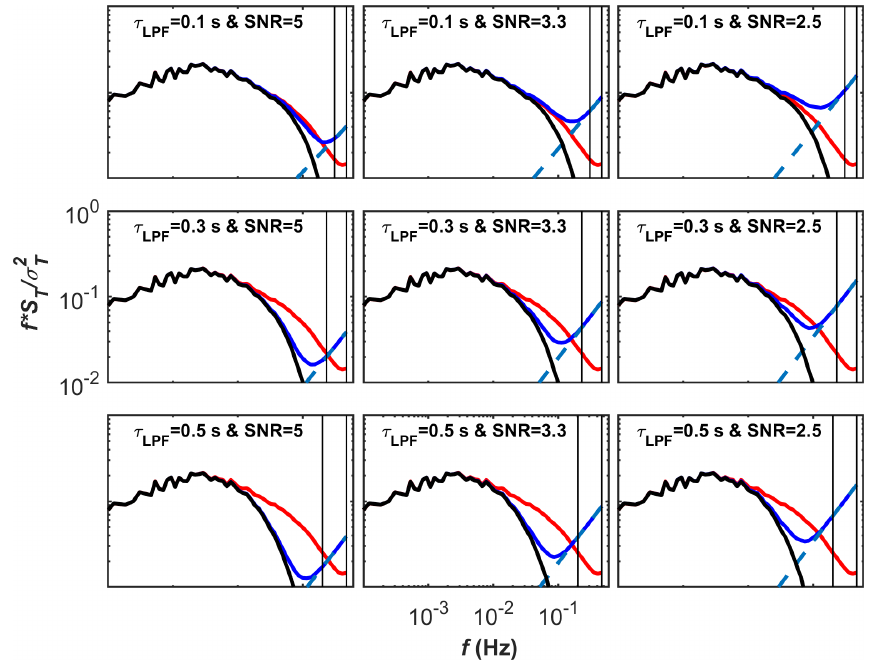
Figure 4. Effect of several low-pass filtering ( τ LPF = 0 . 1, 0.3, and 0.5s) and SNR (5, 3.3, and 2.5) on spectra of sonic temperature ( T ) of 70 half-hourly data records illustrated in logarithmic scale, where f is natural frequency, S T is spectral density, and σ T 2 is the variance of T . Shown are the spectra of raw measured sonic temperature (red lines) and of the artificially deteriorated (i.e. low-pass filtered and noise superimposed) sonic temperature before (dark blue) and after (black) noise removal following Ibrom et al. (2007a) through the subtraction of the linear fit (dashed blue lines) to the high-frequency end of the deteriorated spectra. The vertical lines mark the frequency range used for fitting for noise removal. The lower thresholds of the frequency range are 3, 2.3, and 2Hz for the attenuation levels of 0.1, 0.3, and 0.5s, respectively.